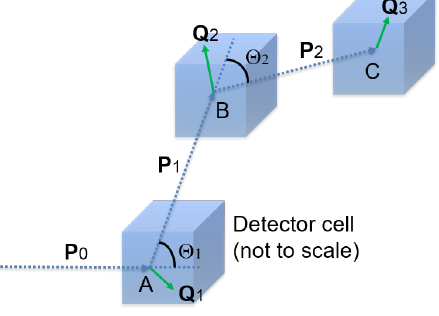
Figure 1. The schematic view of three consecutive recoil ion tracks, induced by a neutron with unknown momentum P 0 . A, B, and C are the vertices of three elastic collisions. Q 1 , Q 2 , and Q 3 are the momenta of the recoil ions (Adapted with permission from Ref. [1]. Copyright Elsevier,